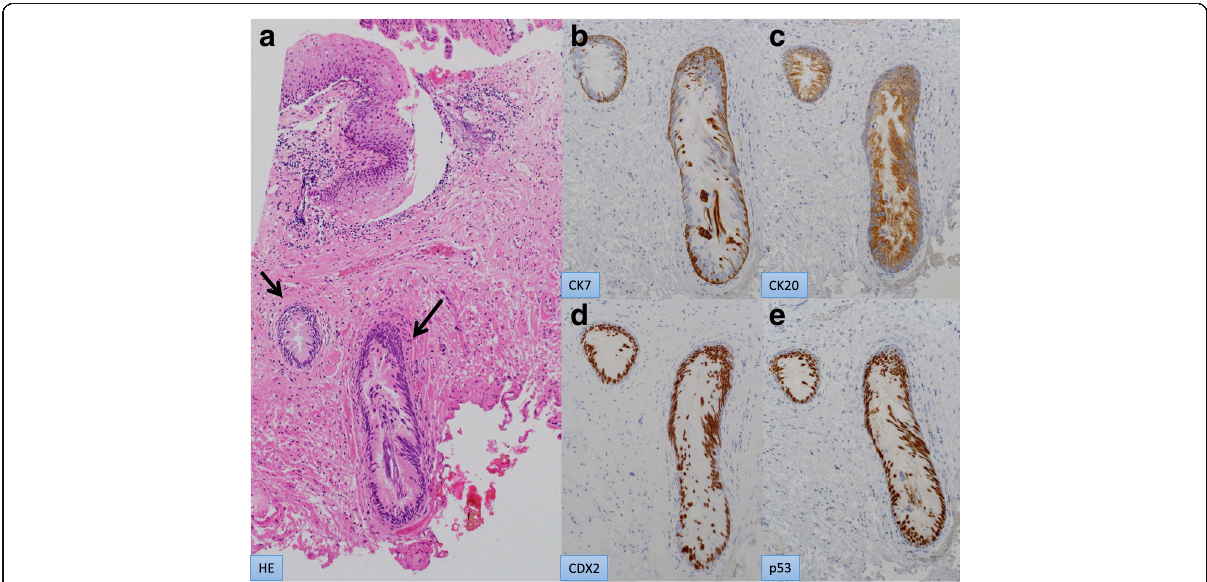
Fig. 6 Histological findings of anal gland carcinoma. a In situ adenocarcinoma of the anal glands (arrow) (hematoxylin-eosin; magnification × 10). b – e Positive immunohistochemical staining for CK7 ( b ), CK20 ( c ), CDX2 ( d ), and p53 ( e ) (magnification ×